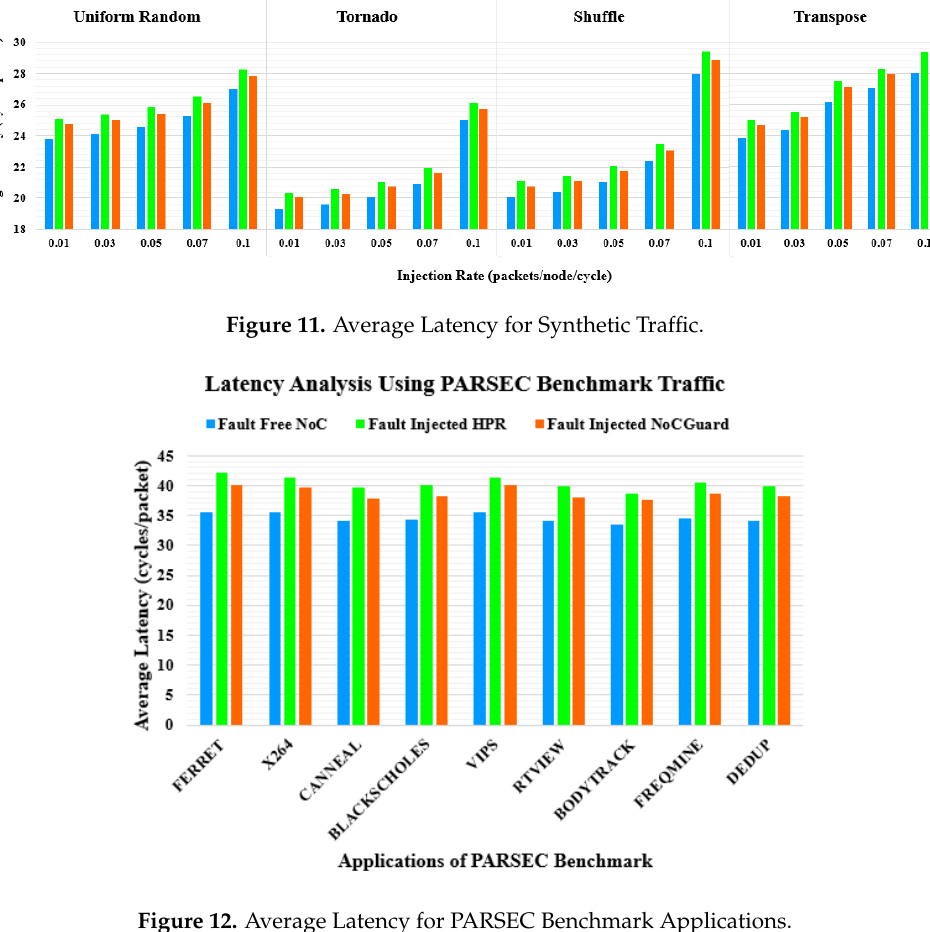
Figure 12. Average Latency for PARSEC Benchmark